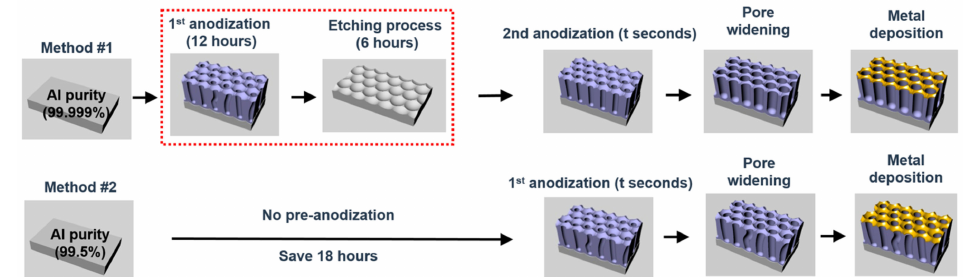
Figure 1. Comparison of the highly ordered anodic aluminum oxide (HO-AAO) fabrication method (method #1) and the one (QU-AAO) developed in this work (method #2). Method #1 begins with a high purity aluminum substrate (99.999%), followed by two anodization steps and a wet etching procedure between them. Metal deposition is performed either directly after the second anodization process or after pore widening process. On the other hand, method #2 uses an inexpensive aluminum substrate (99.5%) and reduces the two anodization steps into one, removing the etching process, thus finally reducing the minimum fabrication time by 18 h and saving 30 times cost.